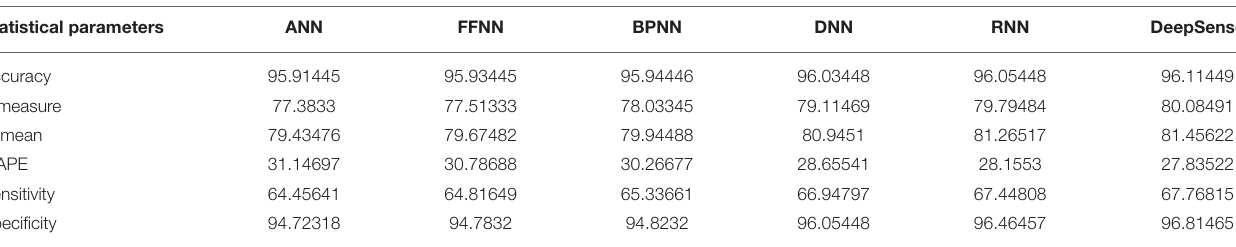
TABLE 7 | Results of statistical parameters for IEEE8023 with 90% training data on 1,000 images. Statistical